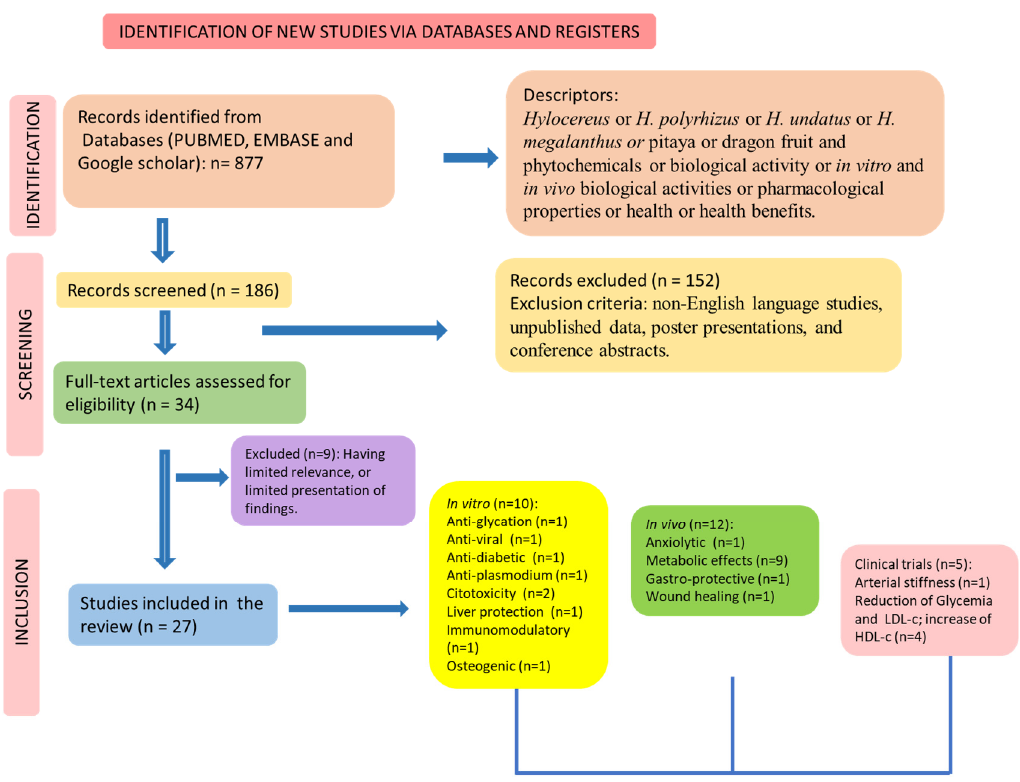
Figure 3. Flow diagram showing the search of the included studies performed with humans (ac ‐ cording to Page et al. [13]